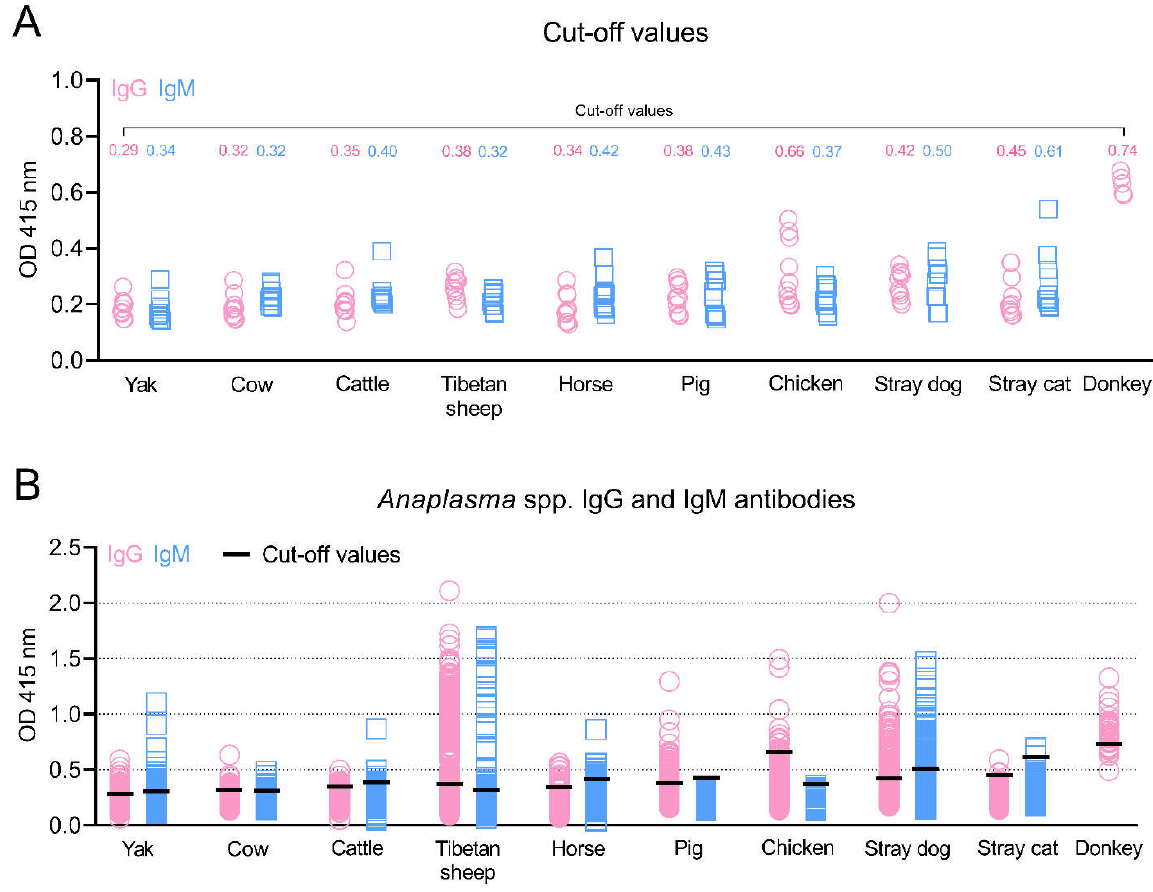
Figure 1. The recombinant MSP5 protein of Anaplasma was expressed. SDS-PAGE analysis was performed by adding 20 μL samples diluted with the loading buffer is 2 X SDS. The results showed the rMSP5-GST in fractions 1 (Protein concentration is 2 mg/μg), 2 (Protein concentration is 1 mg/μg) and the GST in fractions 3 (Protein concentration is 2 mg/μg), 4 (Protein concentration is 1 mg/μg).